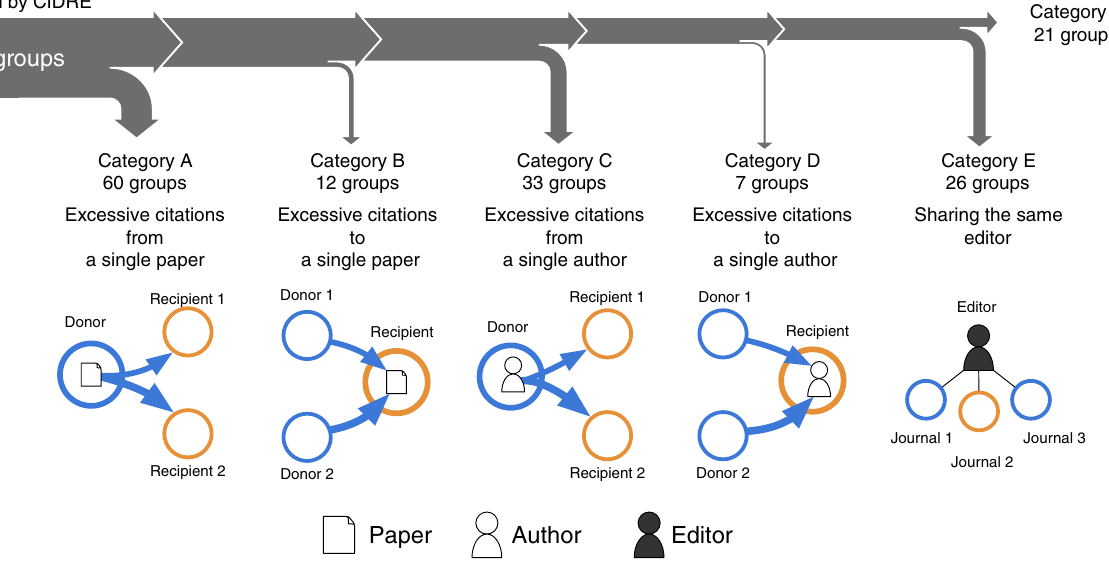
Figure 3. Sankey diagram for the classification of groups. We sequentially apply five classification criteria based on citation patterns (A–D) or the overlap of editorial board members (E). Groups are classified into